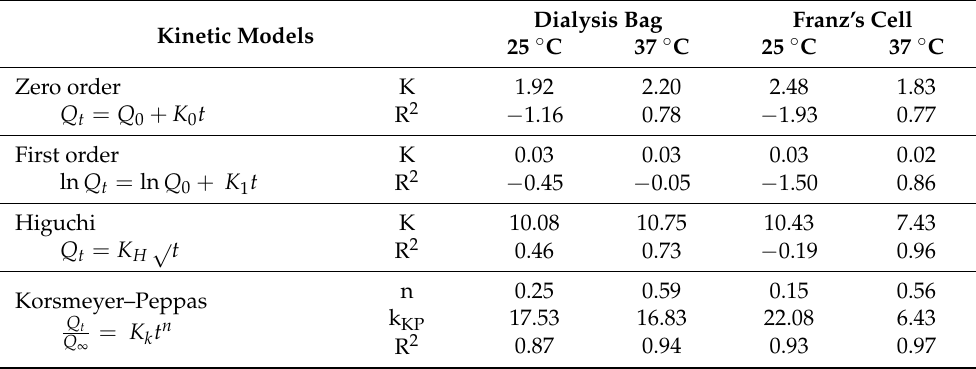
Table 3. Kinetic fit evaluation to NLC-Rho at 25 ◦ C and 37 ◦ C in dialysis bag and vertical Franz’s cell. In equations Q 0 and Q t is the initial amount of Rho and the amount of Rho dissolved at time t, respectively. Q t /Q ∞ is the fractional release of Rho, K 0 is the zero order constant, K 1 is the first order constant, K H is the Higuchi constant, k KP is the Korsmeyer-Peppas constant and n is the diffusional exponent. Kinetic